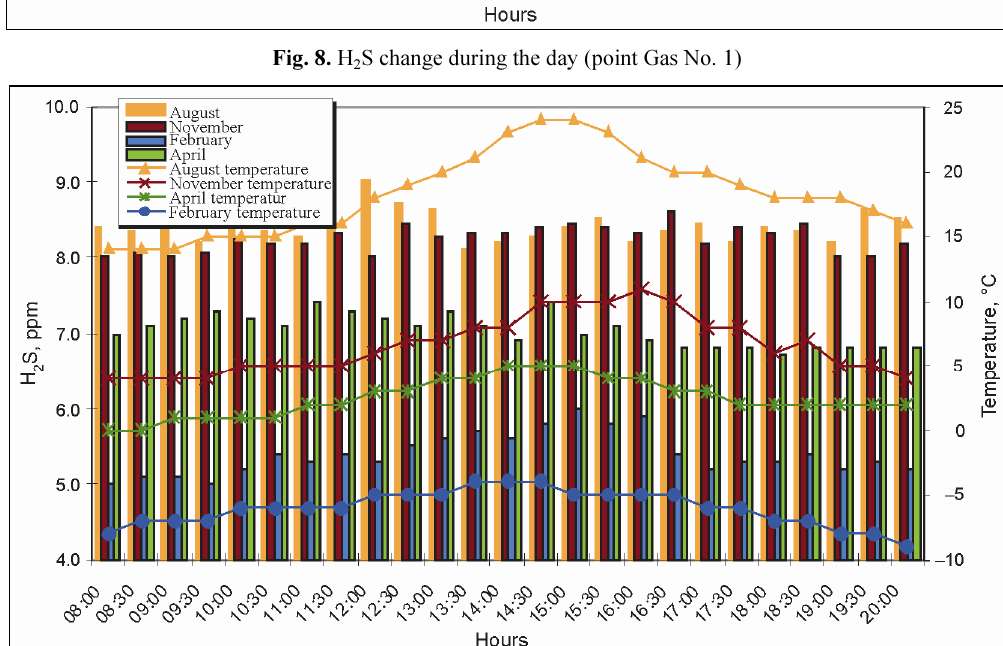
Fig. 9. H 2 S change during the day (point Gas No.